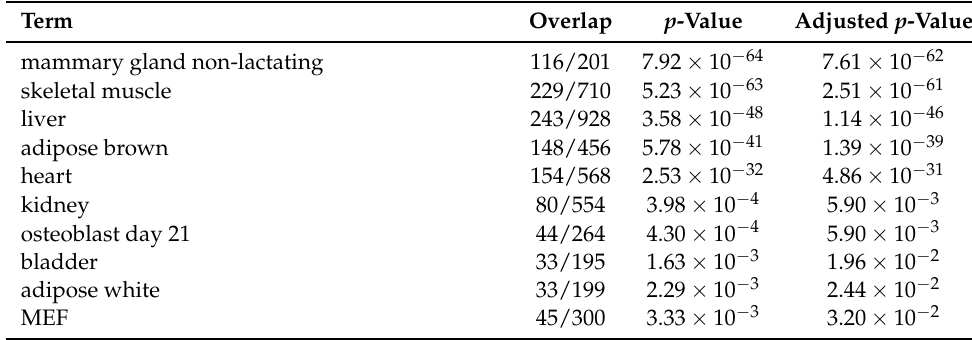
Table 3. Top 10 terms in the “Mouse Gene Atlas” category in Enrichr.